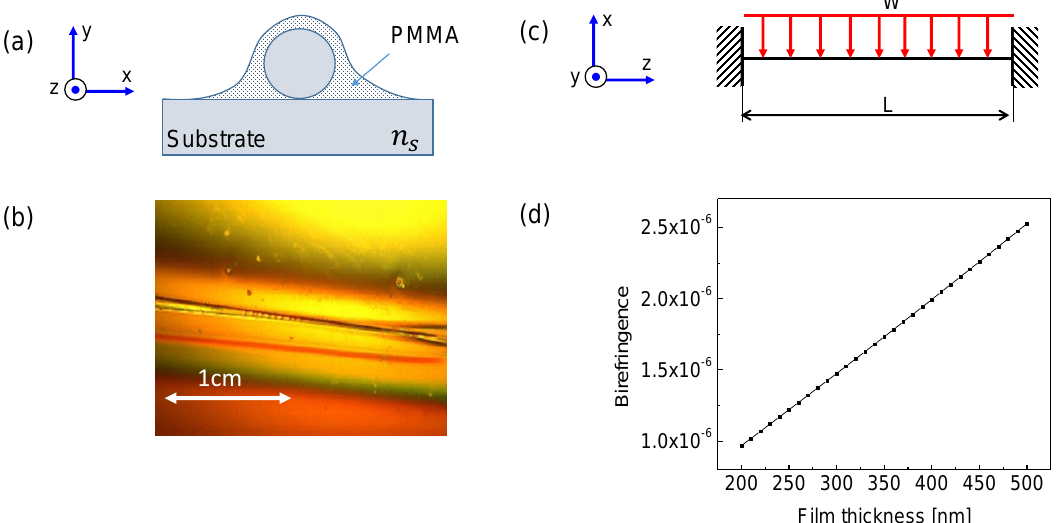
Figure 1. ( a ) Schematics of the cross-section and axes definition in a coated cylindrical taper on substrate ; ( b ) microscope image of the coated taper as viewed from above. ( c ) Schematics of the side view in doubly-clamped fiber segment with the mechanical model of load distribution; ( d ) birefringence strength as a function of the film thickness as calculated using the model (Equations